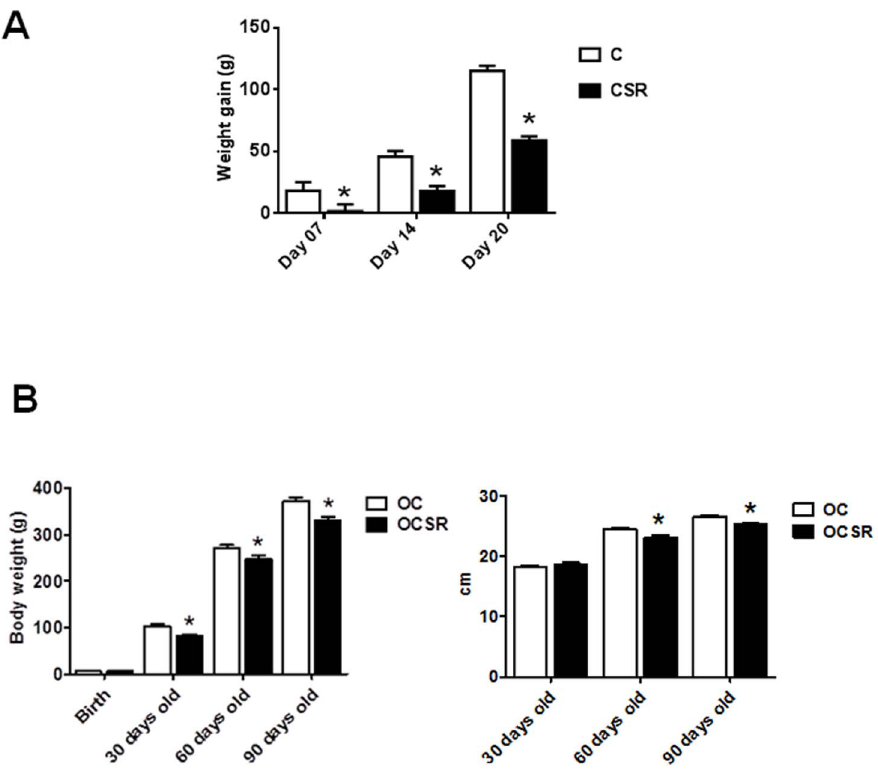
Figure 1. Weight gain during pregnancy, C refers to the control mothers and CSR to the chronically sleep restricted mothers. (A). Body weights (left) and naso-anal measurements (right) of the OC (offspring from the control mothers) and from the OCSR (offspring from the chronically sleep restricted mothers) groups (B). Data are reported as the means 6 SEM. * p # 0,05 vs. the C group (Student’s t-test).